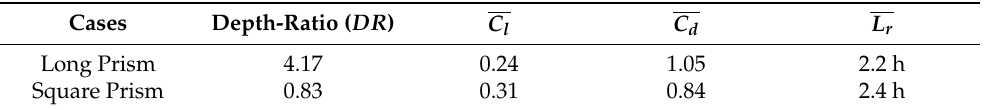
Table 2. Time-average coefficients of lift ( C l ) and drag ( C d ) and recirculation length ( L r ) for both prisms at Re =